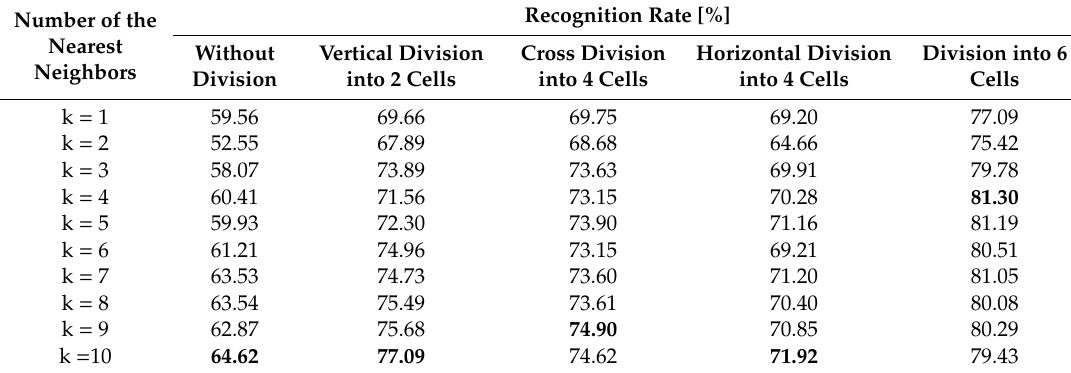
Table 3. Comparison of the recognition rates for the MSR-Action 3D set, k-NN with DTW, and LOSO ten-fold cross-validation.